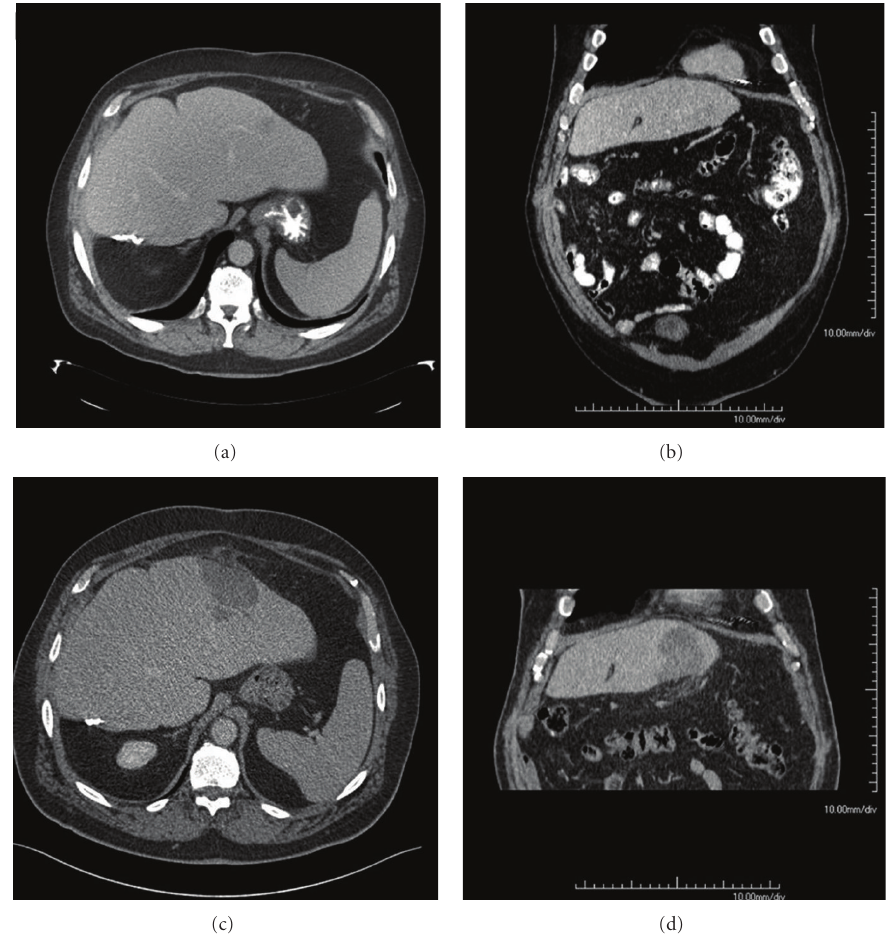
Figure 2: Similarity of Positioning Score-identical (SiPS-id). Example of identical (concordant) pre-RFA CT images and post-RFA CT images, classified as Similarity of Positioning Score-identical (SiPS-id). The pre-RFA CT scan ((a) axial, (b) coronal) and the post-RFA CT scan ((c) axial, (d) coronal) are well